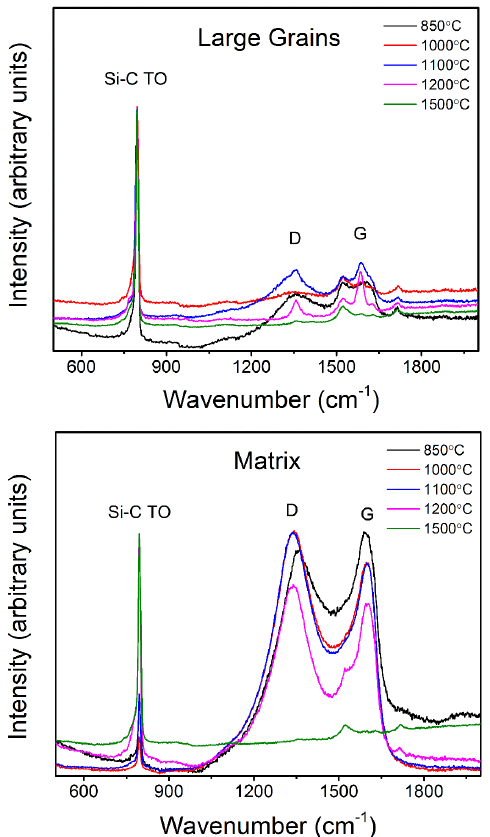
Figure 5. Raman spectra of samples treated at different temperatures for both the large grains ( top ) and the matrix ( bottom ). The large grains seem to remain unchanged while the D and G peaks for the matrix areas show a gradual decrease with increasing temperature and disappear at 1500 °C.